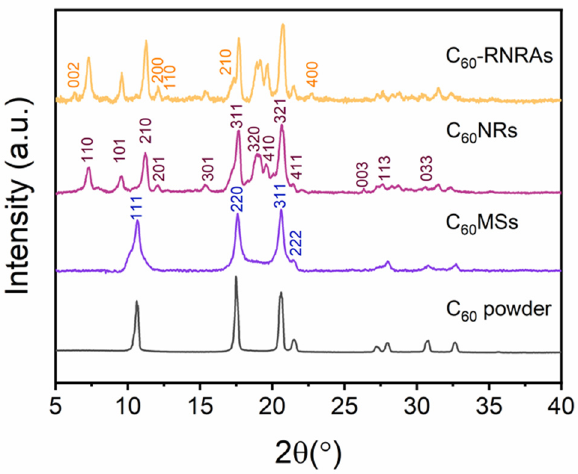
Figure 3. Powder XRD patterns of C 60 powder, C 60 MSs , C 60 NRs, and C 60 -RNRAs . FTIR spectra of C 60 MSs , C 60 NRs, and C 60 -RNRAs are shown in Figure 4a. All three TG analysis of C 60 powder, C 60 MSs , C 60 NRs , and C 60 -RNRAs are then carried out samples show typical absorption bands of C 60 at 1429, 1182, 574, and 526 cm − 1 [42]. The absorption bands of C 60 MSs at 1461 and 728 cm − 1 can be assigned to the C-H bending